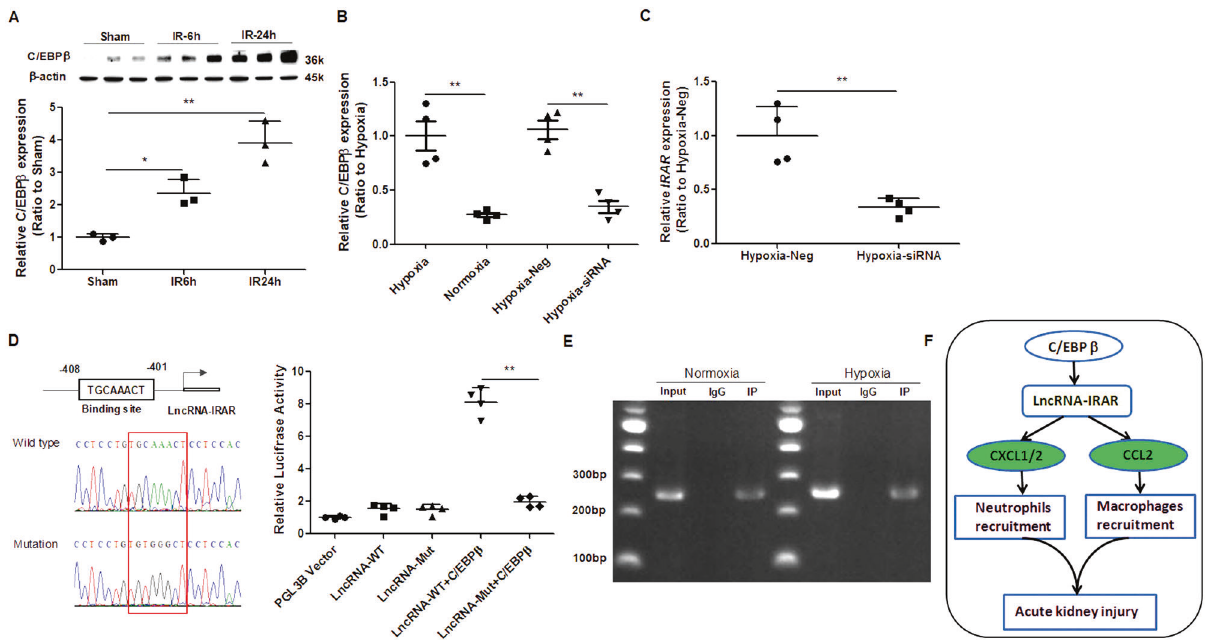
Fig. 8 IRAR is regulated by the transcription factor C/EBP β during renal ischemia reperfusion. A Western blot analysis of C/EBP β during renal ischemia reperfusion. B qRT-PCR analysis of C/EBP β . mTECs were transfected with C/EBP β siRNA (Hypoxia-siRNA) or negative control oligonucleotides (Hypoxia-Neg), and then subjected to hypoxia. C qRT-PCR analysis of IRAR in hypoxia-treated mTECs transfected with C/EBP β siRNA or negative control. D Luciferase reporter assays were performed to determine the C/EBP β binding on the IRAR promoter region. Prediction and mutation of C/EBP β -binding site in the IRAR promoter region (left). Luciferase activity was shown as relative luciferase activity normalized to Renilla activity (right). E ChIP assays were performed to detect C/EBP β occupancy in the IRAR promoter region. IgG was as negative control. F Schematic representation of lncRNA-IRAR-mediated renal ischemia-reperfusion injury. Data represent mean ± SEM. n = 4. * p < 0.05, ** p <